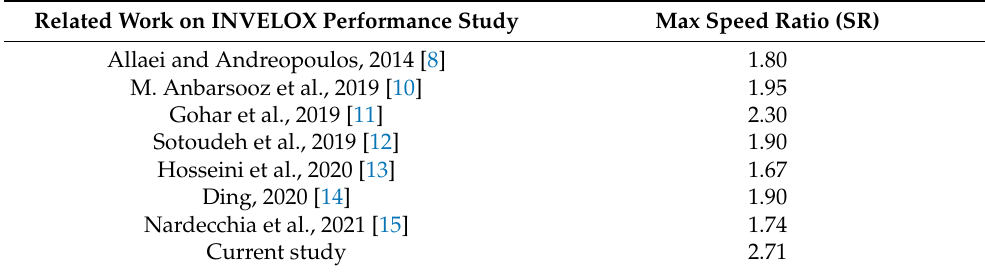
Table 2. Comparison with previous research of the performance of the proposed omni-directional wind funnel in terms of its speed ratio (SR).